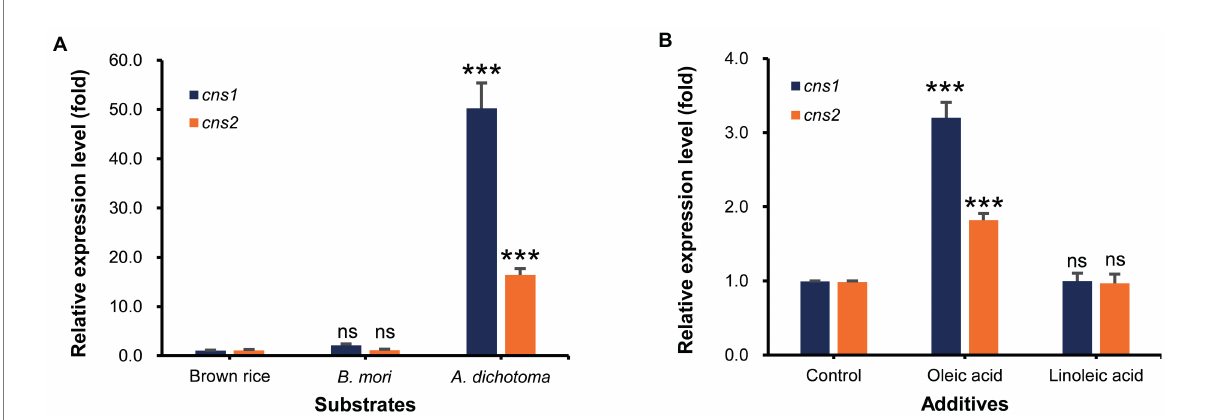
FIGURE 3 (A) Relative expression levels of cns1 and cns2 in Cordyceps grown on Allomyrina dichotoma , Bombyx mori , and brown rice. (B) Relative expression levels of cns1 and cns2 in Cordyceps grown on A. dichotoma without (control) or with additions of oleic or linoleic acid. ns. indicates no significant differences, while, *** p < 0.001 indicates significant